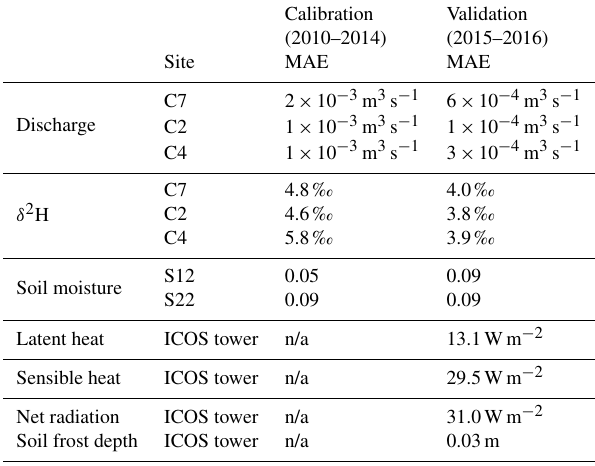
Table 2. Calibration and validation efficiency criteria, shown as mean efficiency for all multi-calibration